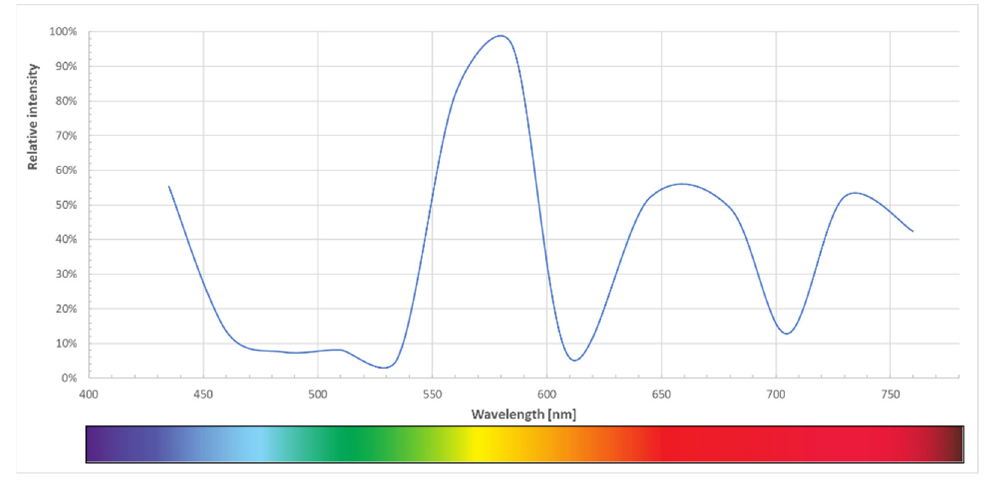
Figure 1. Spectrum of LED bulb.